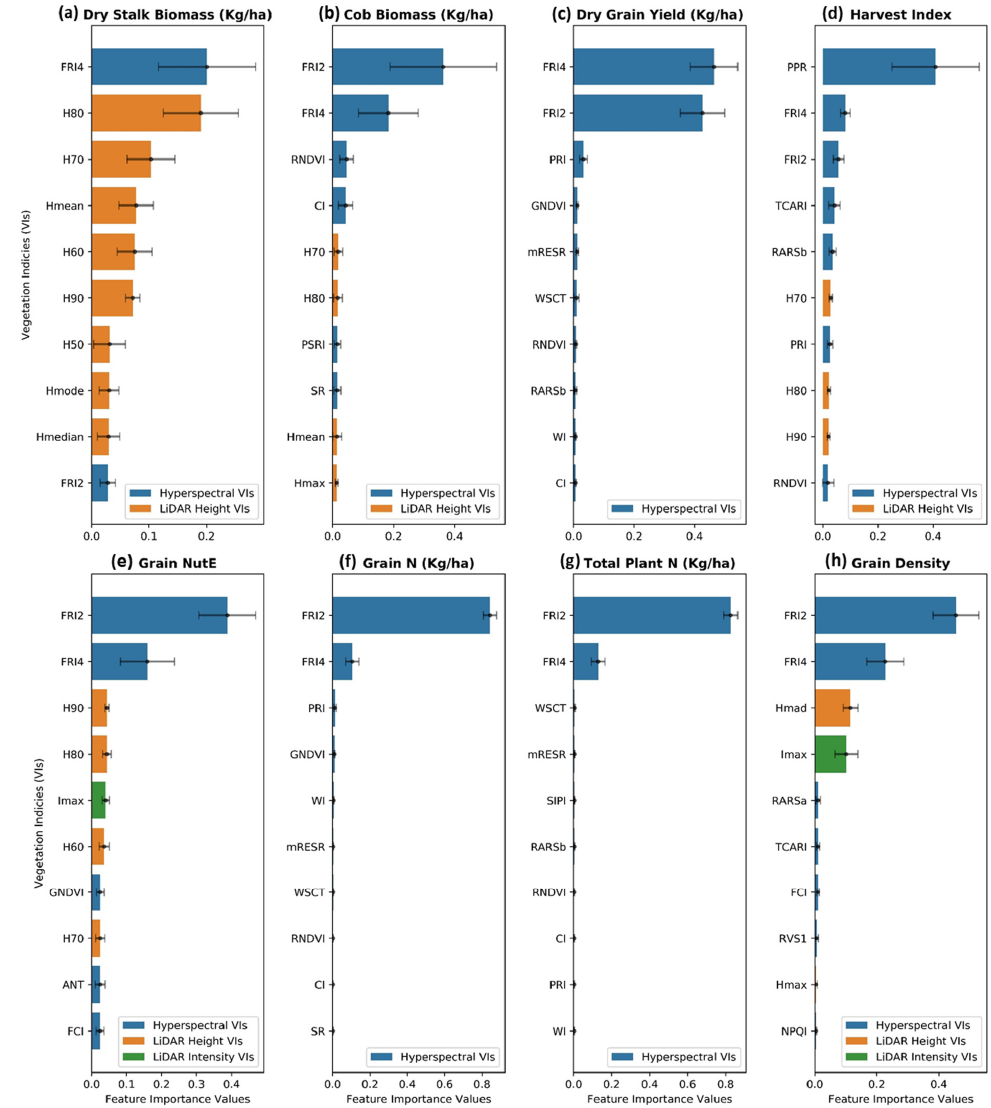
Figure 10. The 10 most important vegetation indices in a descending order of feature importance analysis performed by the mean decrease impurity (MDI). Stalk biomass was found to be estimated the most accurately by fusing data modali-